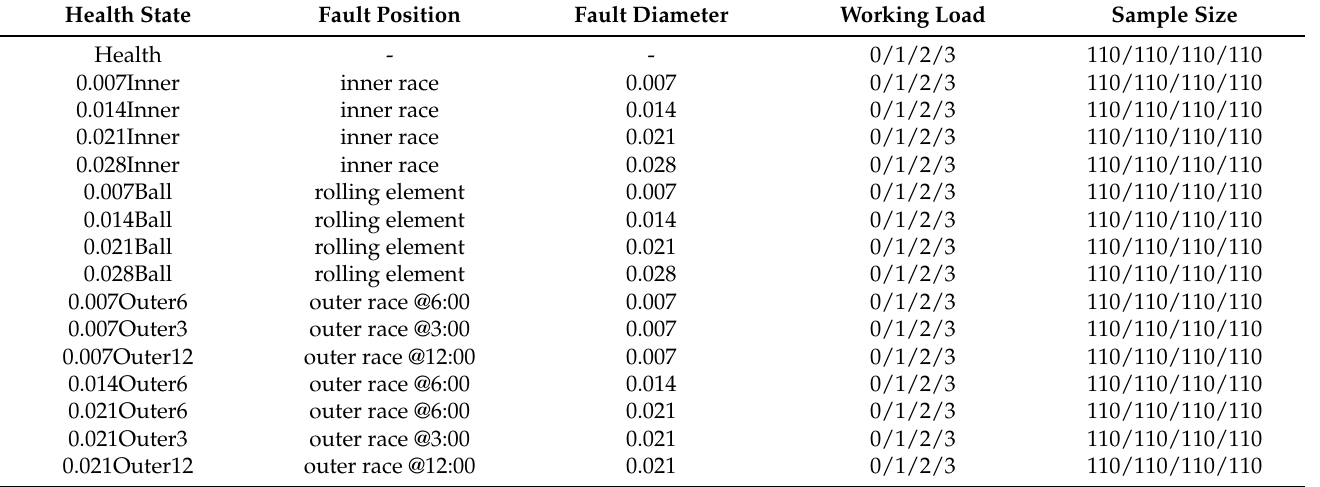
Table 1. Detailed description of CWRU